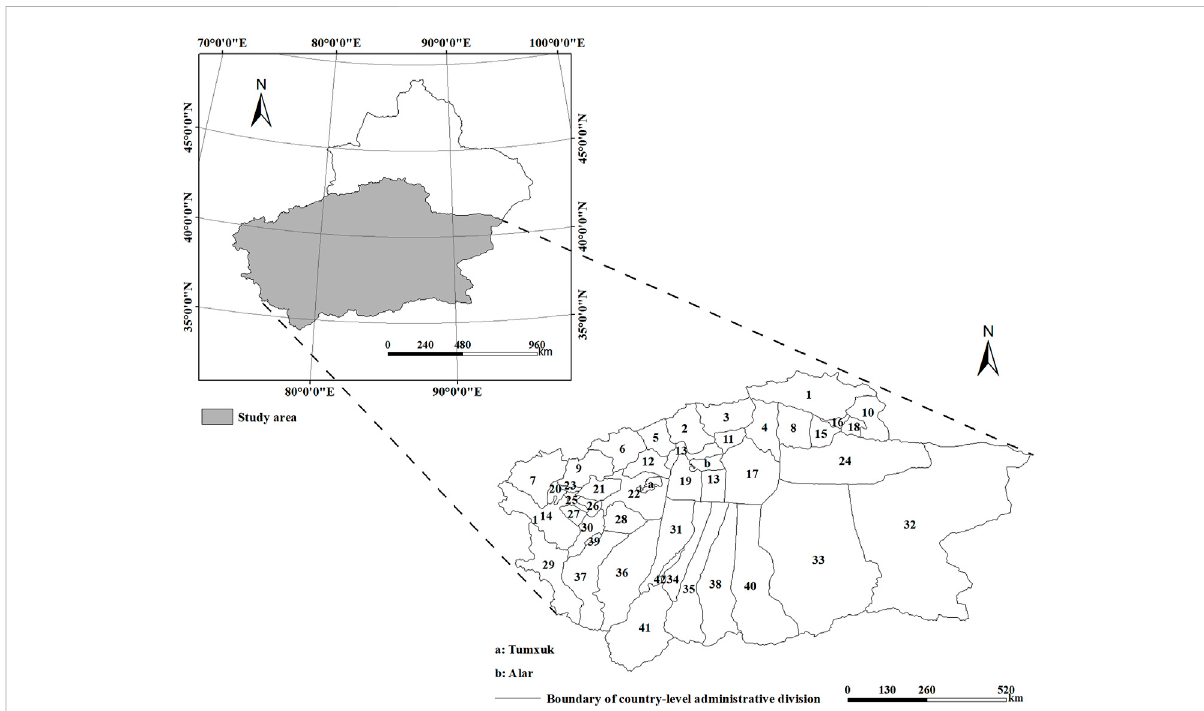
FIGURE 1 Locationofstudyarea.Note: 1.HejingCounty;2.Wensu(Onsu)County;3.Baicheng(Bay)County;4.KuqaCounty;5.Wushi (Uqturpan)County; 6.AkqiCounty; 7.Wuqia(Ulugqat) County;8.Luntai(Bugur) County; 9.ArtuxCity;10.HoxudCounty;11.Xinhe(Toksu)County; 12.KalpinCounty;13. AksuCity; 14.AktoCounty;15.KorlaCity;16.YanjiHuiAutonomous County;17. XayarCounty;18.Bohu(Bagrax)County;19.AwatCounty;20.Shufu County; 21. Jiashi (Payzawat) County; 22. Bachu (Maralbexi) County; 23.Kashi (Kaxgar) City; 24. Yuli (Lopnur) County; 25. Shule County; 26. YopurgaCounty;27.YengisarCounty; 28.MarkitCounty;29. TaxkorganTajikAutonomousCounty;30.Shache(Yarkant)County;31.Moyu (Karakax) County; 32. Ruoqiang (Qarkilik) County; 33. Qiemo (Qarqan) County; 34. Lop County; 35. Qira County; 36. Pishan (Guma) County; 37. Yecheng (Kagilik) County; 38. Yutian (Keriya) County; 39. Zepu (Poskan) County; 40. Minfeng (Niya) County; 41. Hotan County; and 42. Hotan City. The study area does not include territorial country-level cities (a,b)